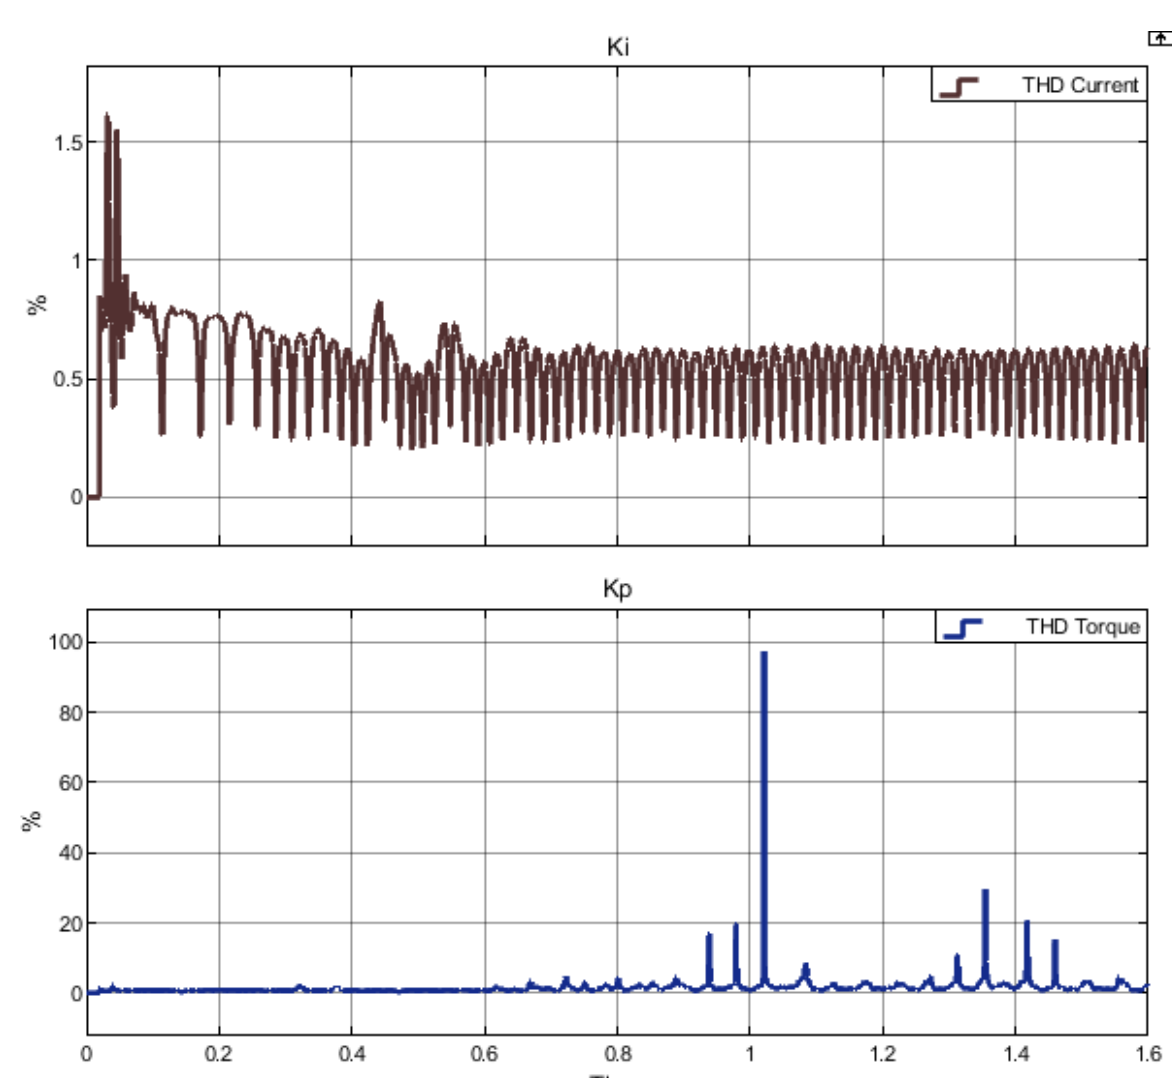
Figure 8. Change in harmonic distortion coefficient K I and electromagnetic moment pulsation coefficient Σ K p in normal operating state of electric motor without defects.